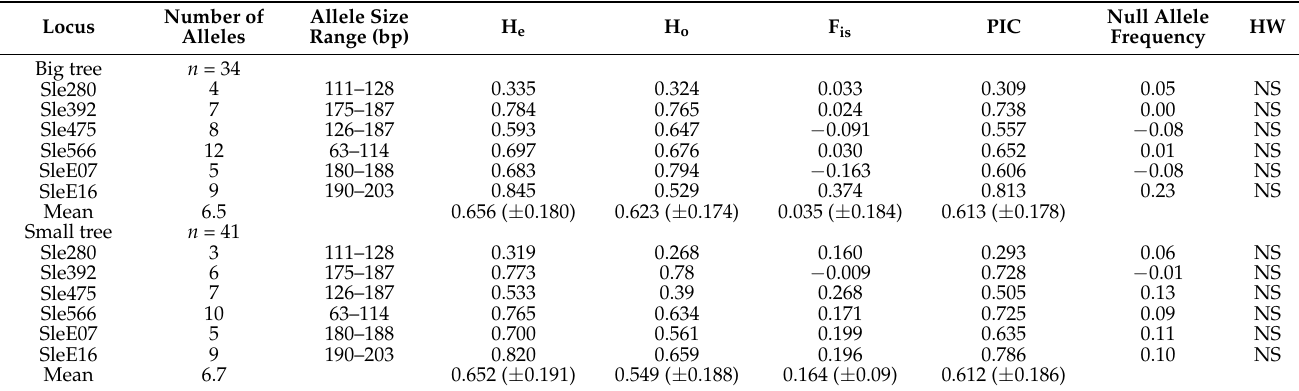
Table 3. Four microsatellite SSR primers and two microsatellite EST-SSR primers developed for S. leprosula and transferability to 75 S. acuminata in compartment 107, Kenaboi FR: expected heterozygosity (H e ); observed heterozygosity (H o ); inbreeding coefficient (F is ); polymorphic information content (PIC); Hardy–Weinberg (HW); not significant (NS). Figures in the brackets are the estimated standard errors of the mean for genetic diversity